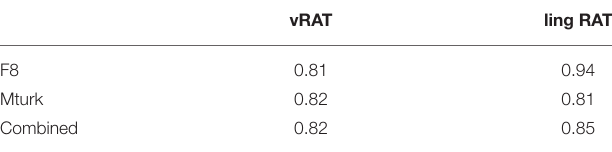
TABLE 6 | Cronbach’s alphas of the accuracy metrics of Study-2.